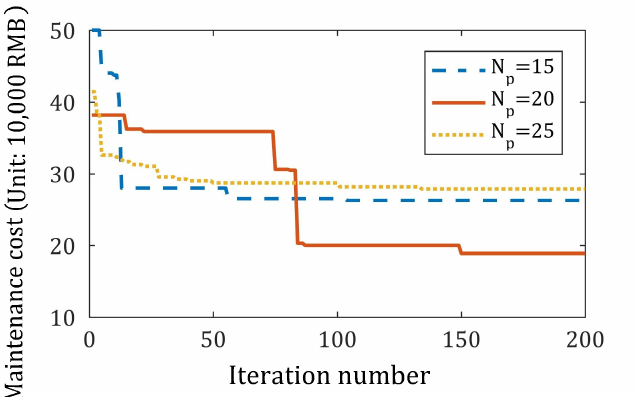
Figure 12. Iterative curves of the optimization objective under different values of N p when w = 0.5 and v max =